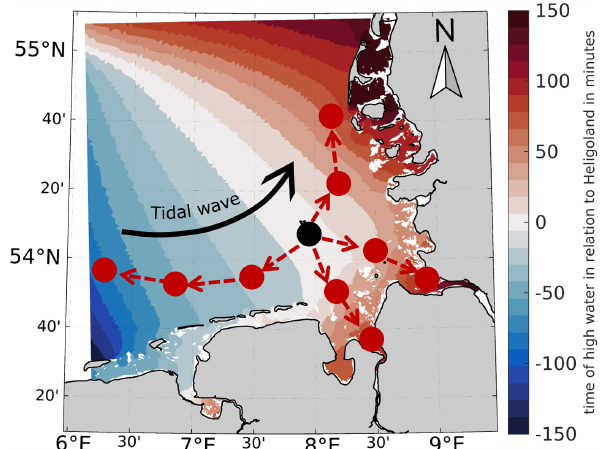
Figure 5. Schematic overview of the tidal analysis methodology throughout the German Bight, showing the main reference position in black and the predecessor and successor positions in